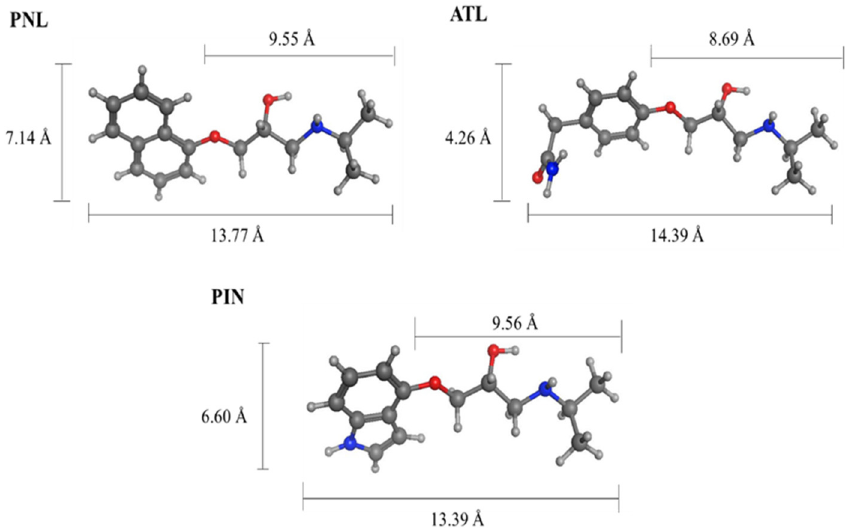
Figure 3. Chemical structures showing the sizes of propranolol ( PNL ), atenolol ( ATL ), and pindolol ( PIN ). Images and sizes generated using the Molecular Operating Environment (MOE) modelling software.